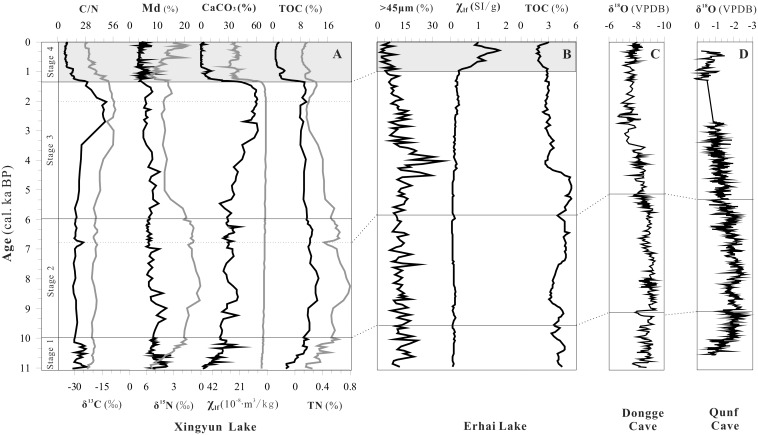
Comparison of the climatic records from Xingyun Lake with the climatic proxies of Erhai Lake and the δ18O of Dongge Cave and Qunf Cave in the Holocene.The period of intensive human activities and the farming agriculture of Xingyun and Erhai Lake was denoted by the gray area. (A) The climatic proxies of Xingyun Lake indicating strength of Asian summer monsoon and record the strengthened human activities in Yunnan plateau; (B)The climatic proxies (grain size >45 µm, χlf and TOC content) of Erhai Lake [1]; (C) The stalagmite δ18O record from Dongge Cave, southwest China [45]; (D) The stalagmite δ18O record from Qunf Cave, Oman [51].